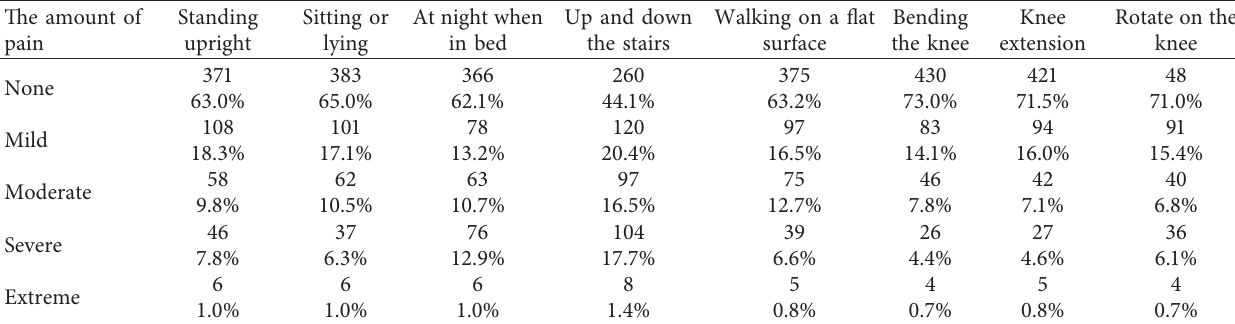
Table 3: The prevalence rate of knee pain when doing various activities.